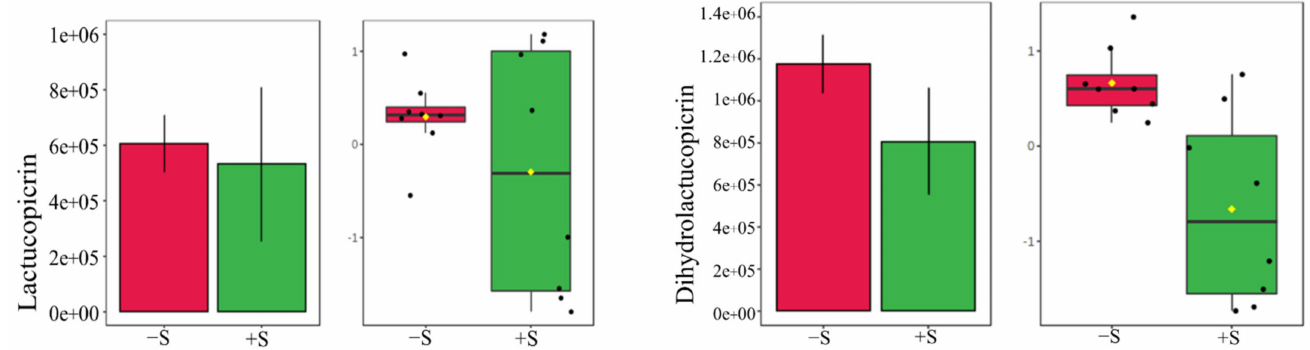
Figure 5. Detailed quantitative analysis of compounds detected in butterhead green lettuce (V1) grown under +S and − S